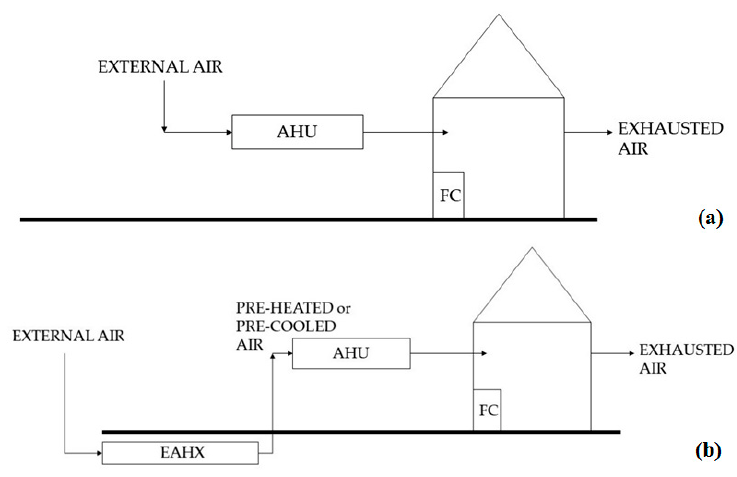
Figure 2. ( a ) HVAC system without EAHX. ( b ) HVAC system with EAHX.